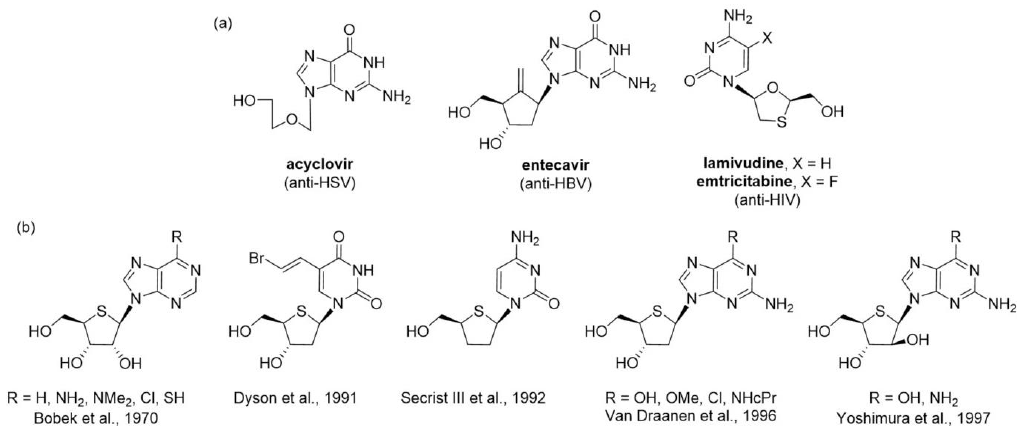
Figure 2. Representative examples of ( a ) essential antiviral nucleosides with non-natural sugar ring compositions, and ( b ) historical 4′-thionucleoside analogs having notable bioactivity.